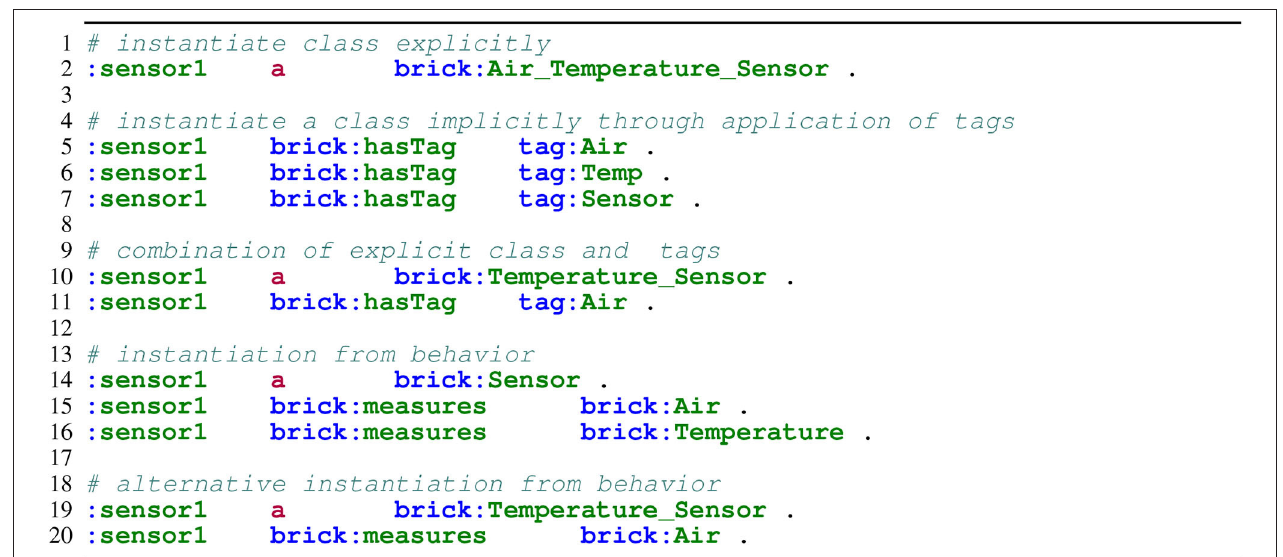
FIGURE 2 | Five equivalent methods of declaring sensor1 to be an instance of the Brick Air Temperature Sensor class.